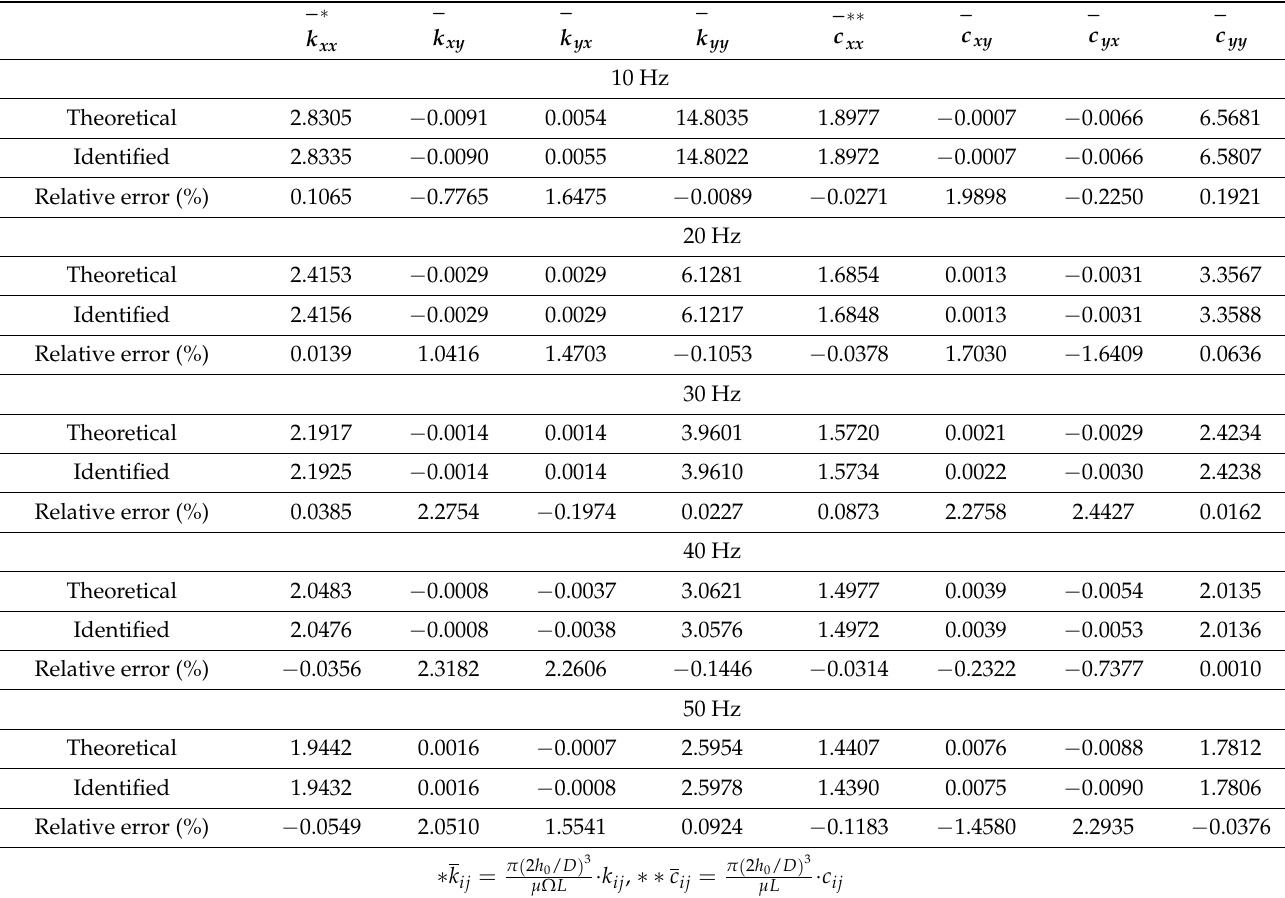
Table 3. Dimensionless identified